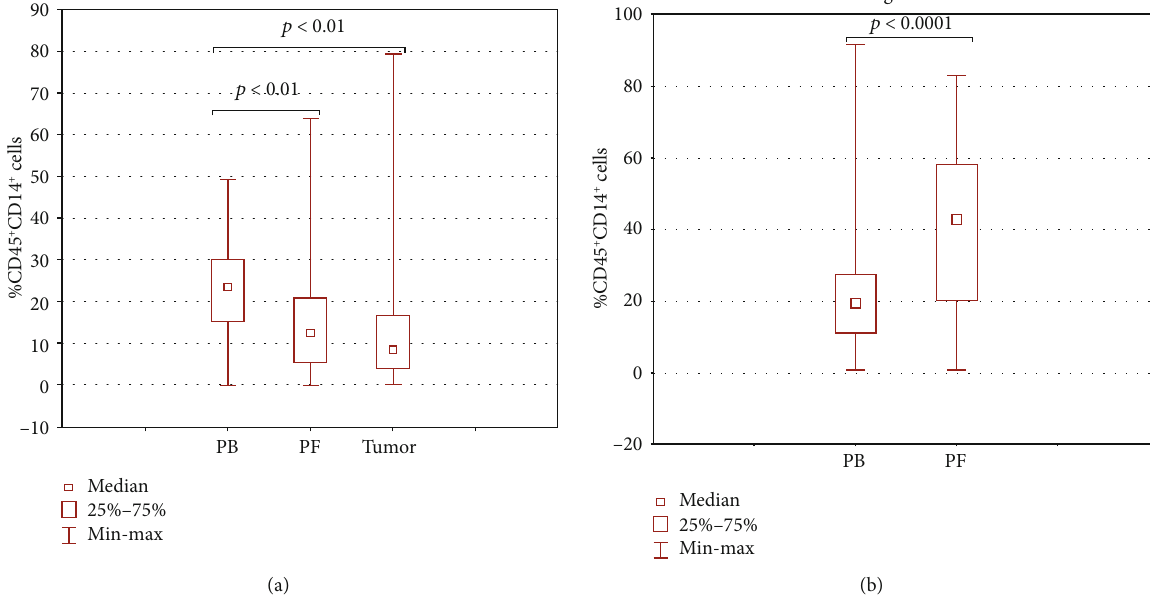
Figure 4: Distribution of CD45 + CD14 + MO/MA in the (a) malignant and (b) nonmalignant ovarian tumor